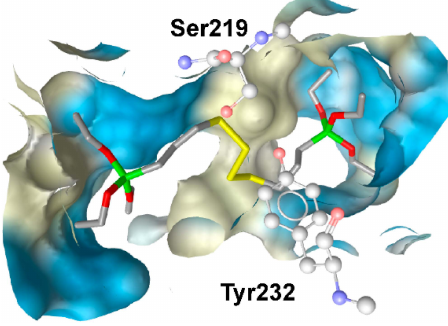
Figure 17. Docking of silane into the homology model of 11 β -HSD2 [78] suggests hydrogen bond interactions with Ser219 and Tyr232